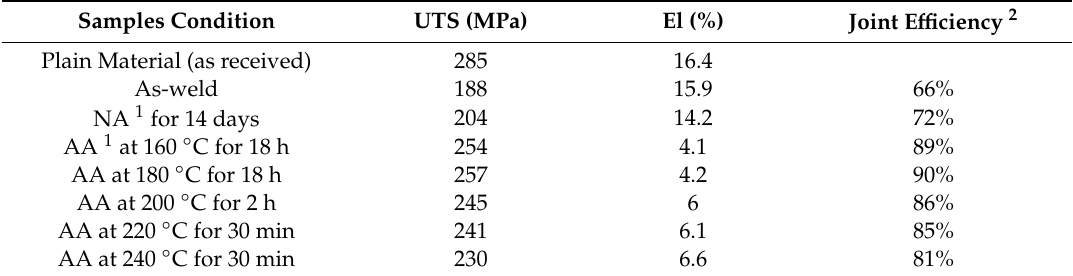
Figure 7. The e ff ect of artificial aging at: ( a ) 180 ◦ C; ( b ) 200 ◦ C; ( c ) 220 ◦ C; ( d ) and 240 ◦ C under di ff erent Figure 7. The effect of artificial aging at: ( a ) 180 °C; ( b ) 200 °C; ( c ) 220 °C; ( d ) and 240 °C under different aging times on the tensile strength of the RAFSW samples. aging times on the tensile strength of the RAFSW samples. Table 1. Tensile properties and joint e ffi ciency of the welds aged naturally and at optimized artificial Table 1. Tensile properties and joint efficiency of the welds aged naturally and at optimized artificial aging aging conditions.